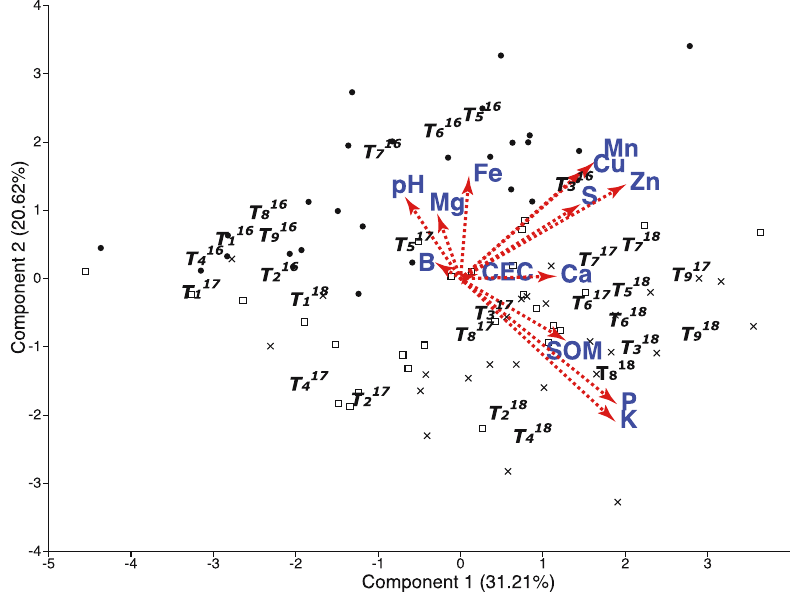
Figure 1: The principal component analysis of topsoil parameters; data for each separate parameter was standardized as z - scores before the analysis. Sample year: dot = year 2016, square = year 2017, and x = year 2018. The labels show the treatment ID, with the year as superscript; each label is located at the centroid of the respective replicates. A similar analysis for subsoil can be found in the Supplementary Data Figure 2.1. A temporal shift can be observed in the distinct clustering of the 2016 ( top left ) and the 2017 – 2018 ( bottom right ) . Directional eigenvectors indicate putative